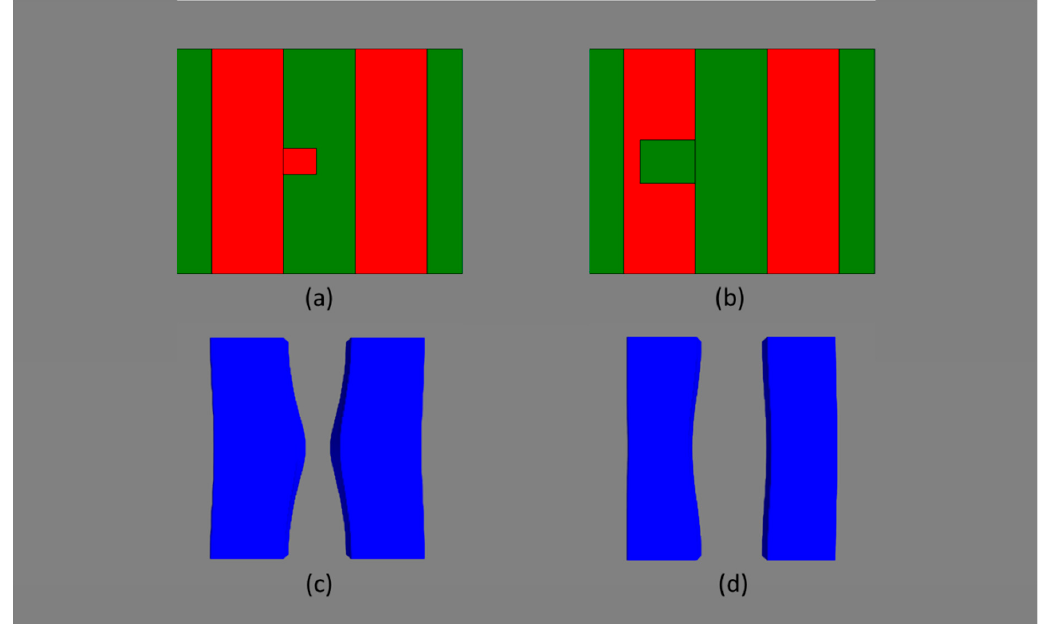
Figure 4. Example for defect printing in 193 nm dry optical lithography. Mask defects considered (65 nm dense lines/spaces with ( a ) 30 nm extrusion and ( b ) 50 nm intrusion; ( c ) and ( d ) resulting resist geometries for ( a ) and ( b ), respectively, for lithography with ideal focus and dose.